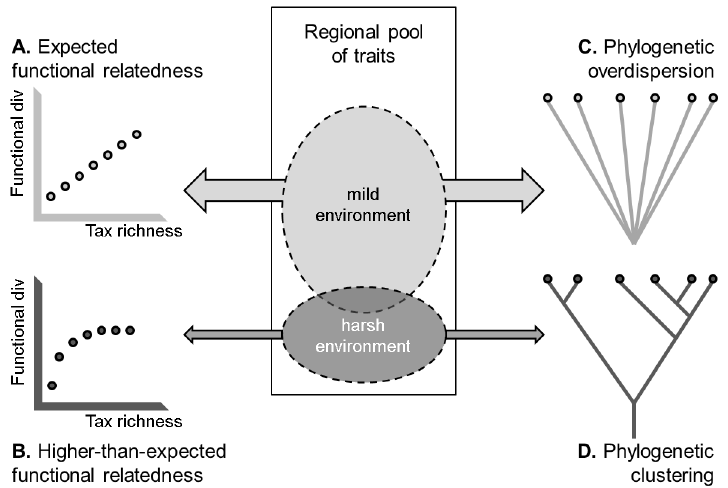
Figure 1. Conceptual framework of trait filtering by climate and expected associated patterns of functional (A, B) and phylogenetic relatedness (C, D). (A) Shows no functional overlap (i.e., expected functional relatedness); (B) shows functional overlap (i.e., higher-than-expected functional relatedness); (C) shows phylogenetic overdispersion; (D) shows phylogenetic